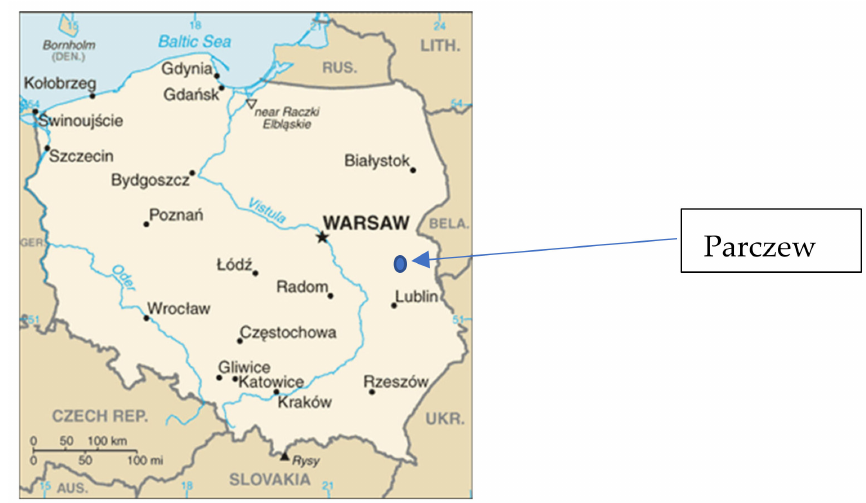
Figure 4. Geographical location of